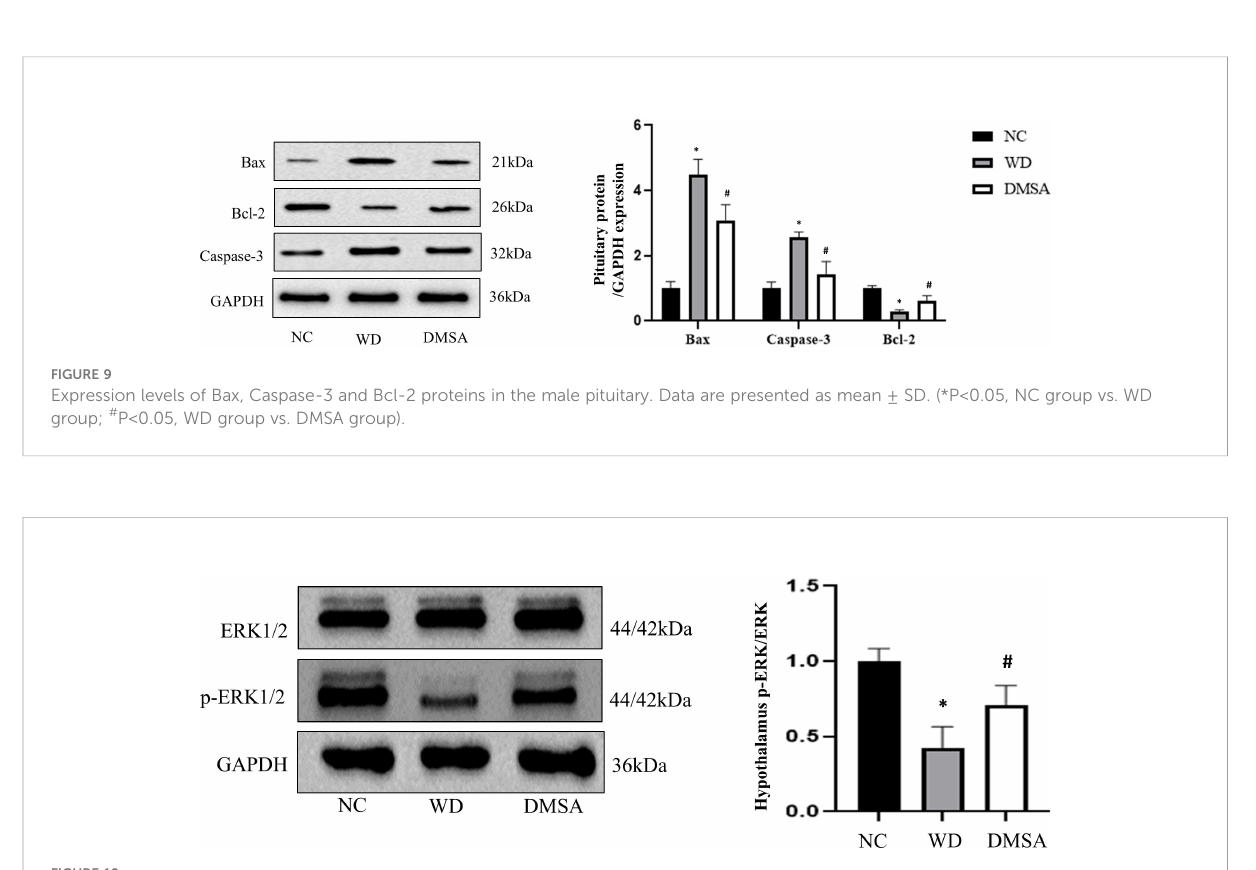
FIGURE 10 Extracellular regulatory protein kinase (ERK) 1/2 phosphorylation in the male hypothalamus. Data are presented as mean ± SD.(*P<0.05, NC group vs. WD group; # P<0.05, WD group vs. DMSA